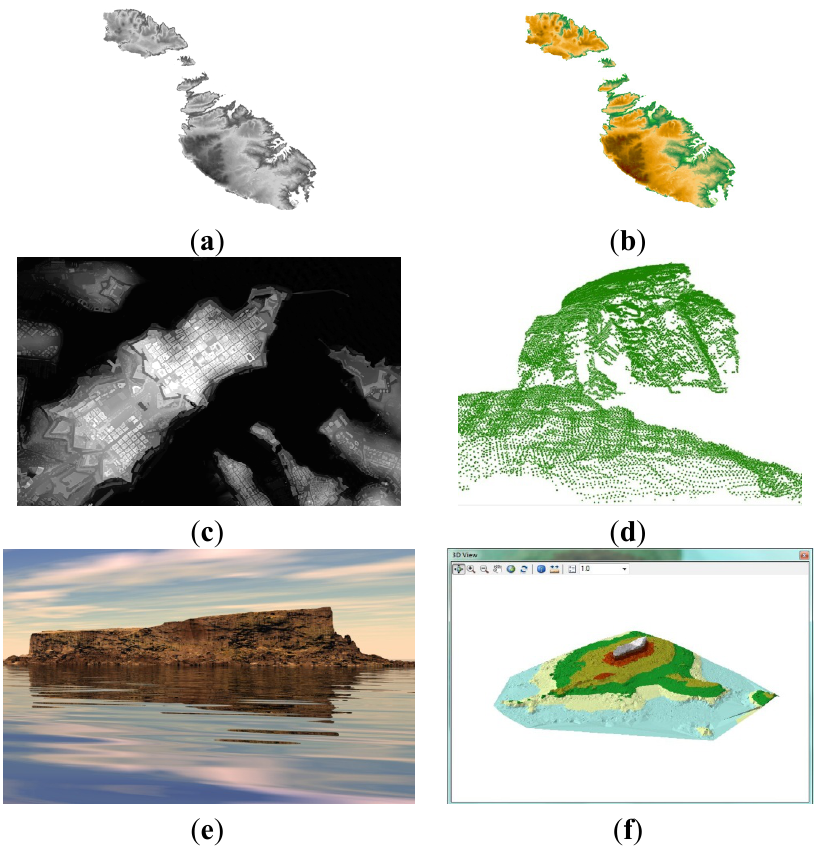
Figure 1. ( a ) Terrestrial LIDAR data integration; ( b ) height map based on LIDAR data; ( c ) Valletta 25 cm raster output; ( d ) Dwejra LIDAR Points; ( e ) Filfla rendering; ( f ) Filfla terrestrial and bathymetric data aggregation; ( g ) Mellie ħ a Height-Depth map; ( h ) Valletta LIDAR cross-sectional perspective; ( i ) Pieta VRML output from tin and ortho-imagery; ( j ) 3d-printed Dwejra haptic